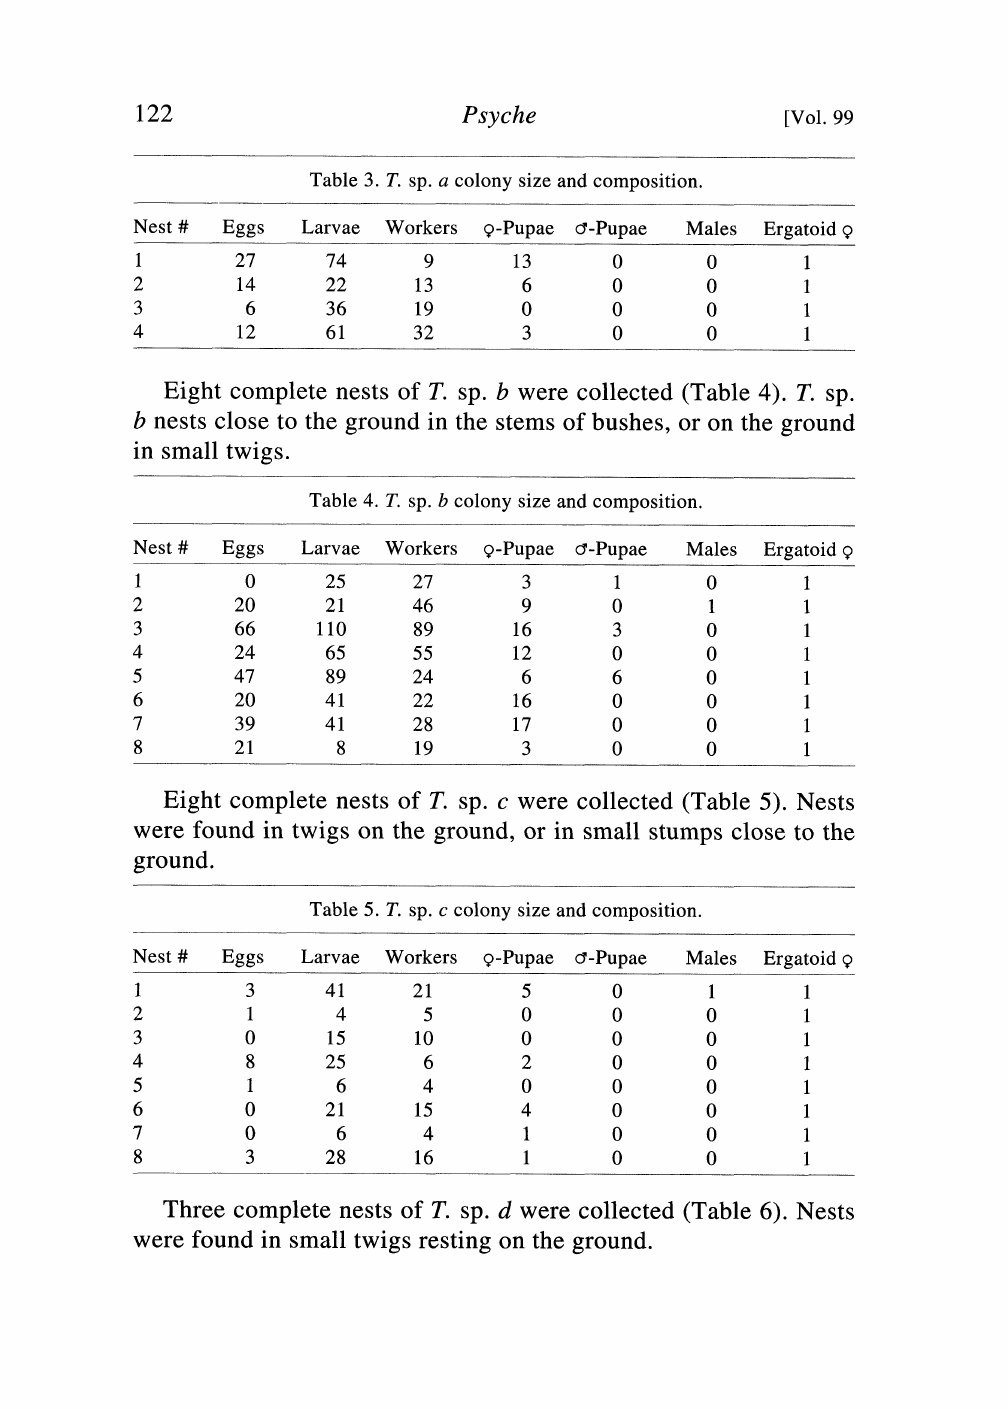
Table 4. T. sp. b colony size and composition.